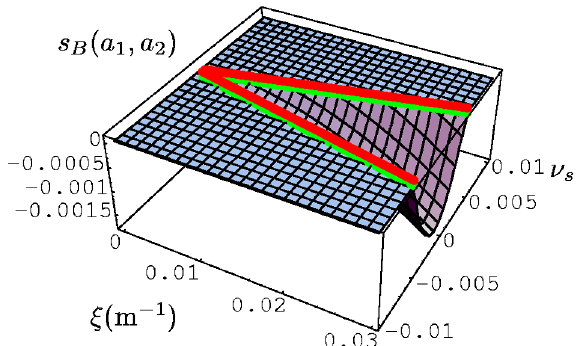
FIG. 4. (Color) Unstable region caused by a crab cavity for small distances (cid:6)(cid:28) above a half-integer tune. Light green: border of stability; dark red: border of stability from the approximation Eq.